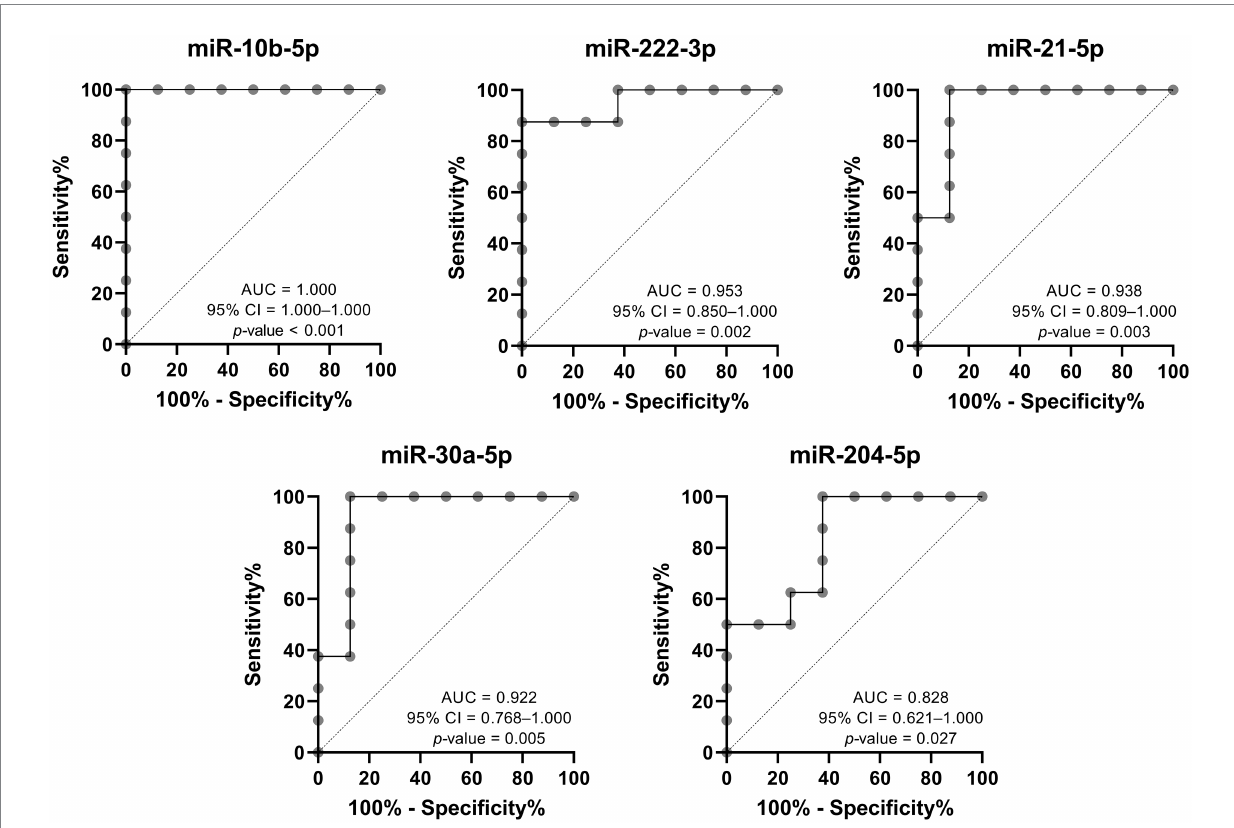
FIGURE 6 Receiver operating characteristic analysis of DE-miRNAs to discriminate between Fabry patients with progressive nephropathy and matched controls. AUC, area under the curve; CI, confidence interval.